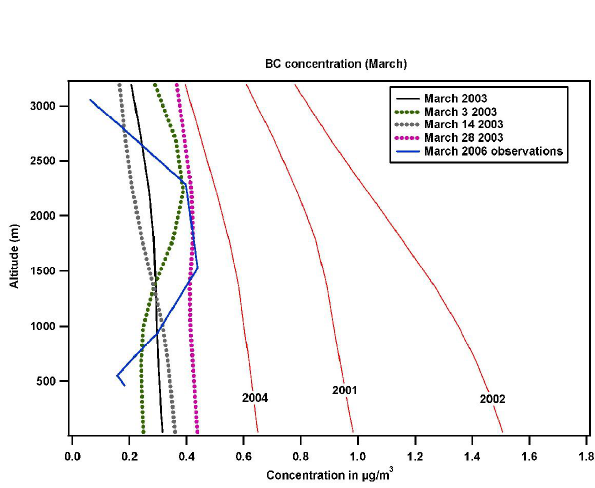
Fig. 7. Monthly BC (black carbon) concentration comparison (in units ofµg/m 3 ) . Blue line displays the MAC observation data over 73.18 ◦ E and 6.78 ◦ N during March 2006 (Ramanathan et al. 2007). Red lines show the present model calculation at a nearby grid (73.36 ◦ E and 6.6 ◦ N) in March 2001, March 2002, March 2003 and March 2004,